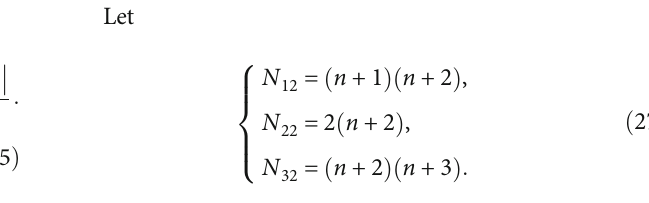
Figure 5: The results of di ff erent impact angles considering FOV